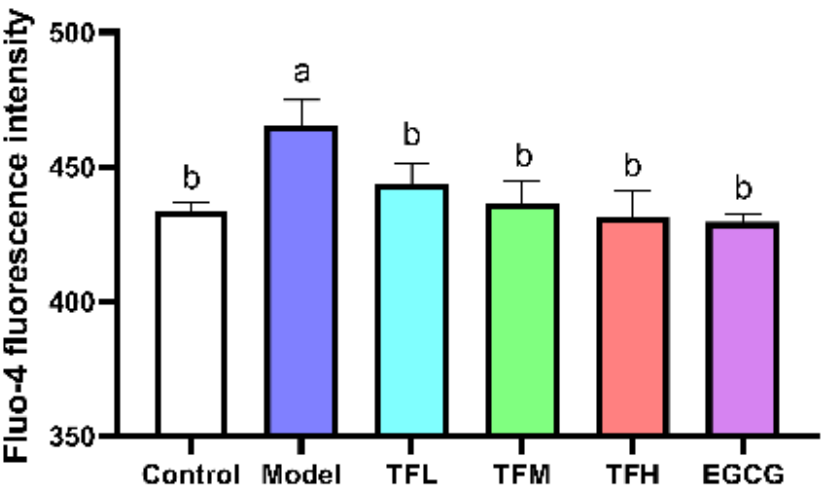
Figure 4. ( a ) ROS level of H9c2 cells treated with different concentrations of TF3 and EGCG. ( b ) NO level of H9c2 cells treated with TF3 and EGCG. ( c ) CAT activity of H9c2 cells treated with TF3 and EGCG. ( d ) SOD activity of H9c2 cells treated with TF3 and EGCG. Control group, no ANGII treat- ment; Model group, ANGII 0.5 μ M induction; TFL group, TF3 1 μ M pretreatment and ANGII 0.5 μ M induction; TFM group, TF3 5 μ M pretreatment and ANGII 0.5 μ M induction; TFH group, TF3 10 μ M pretreatment and ANGII 0.5 μ M induction; EGCG group, EGCG 50 μ M pretreatment and ANGII 0.5 μ M induction. Significant differences between different treatments were shown by dif- ferent letters ( p < 0.05) .